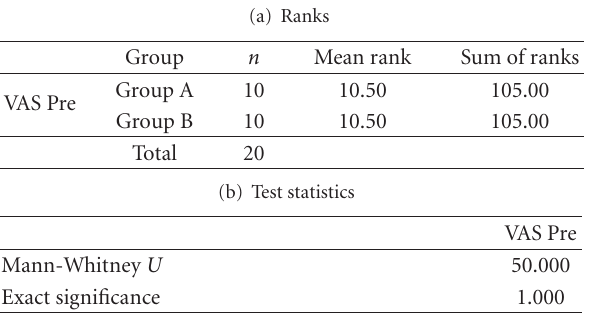
Figure 6: Duration of symptoms (in weeks) in both groups. Table 4: Comparison of Pretest VAS score of Group A and B.